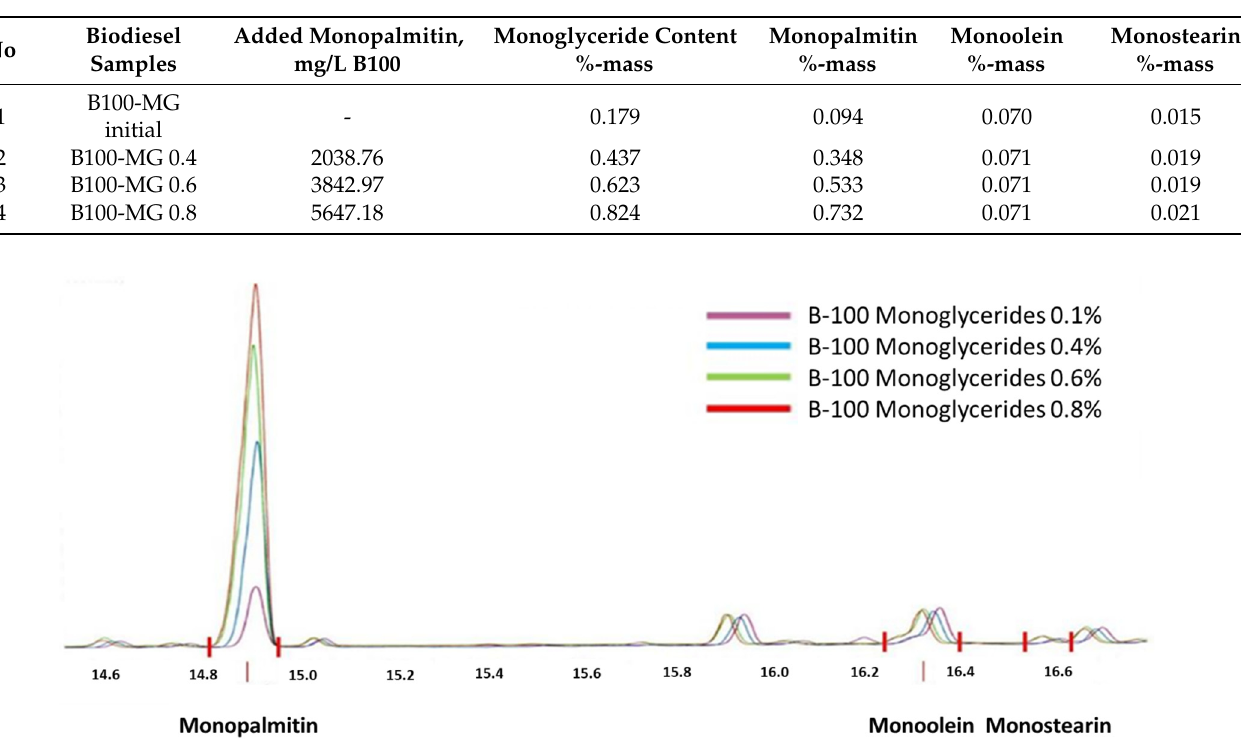
Figure 3. GC Chromatogram for monoglyceride content in biodiesel.